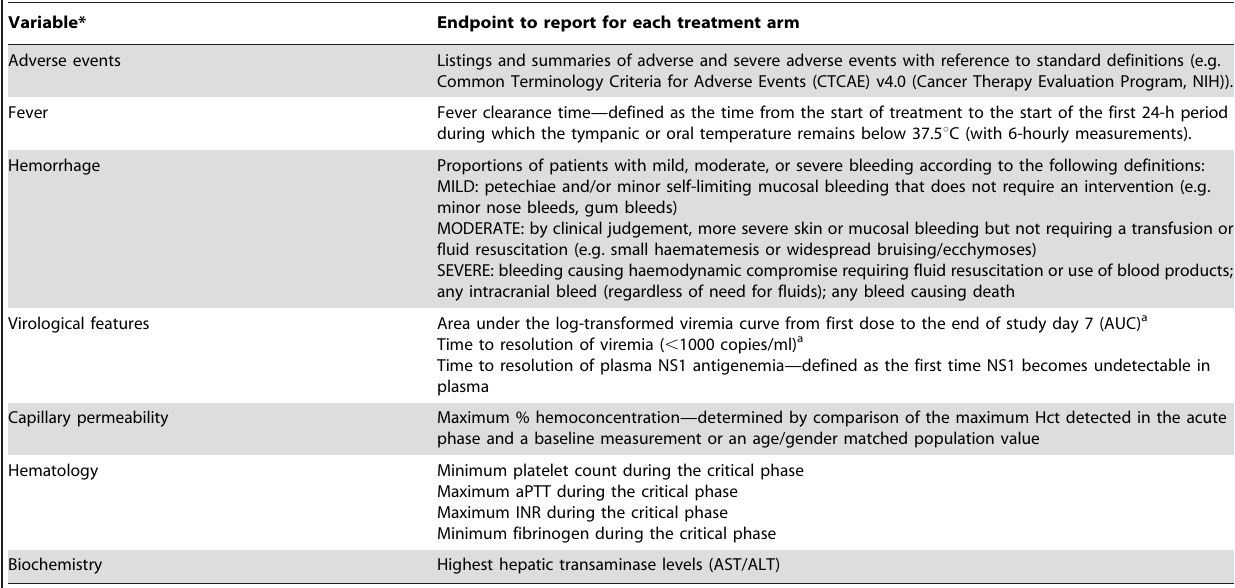
Table 1. Standard analyses and reporting of clinical and virological endpoints in early-phase trials of dengue